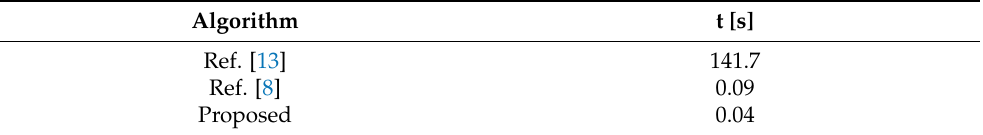
Figure 9. ( a ) Comparison of the blade #1 adimensional vibration estimated with the proposed algorithm and of the estimates obtained by the reference methodology in [8,13] ( Blade Tip Time Averaging—Ives (1986) ) with a zoom ( b ). A smoothed vibration envelope is reported in ( c ). Table 3. Computational times (average over three runs) for the different algorithms on a 3.6 GHz CPU and 32 GB RAM machine.